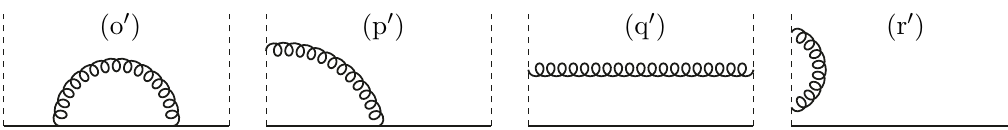
Figure 6 . One-loop Feynman diagrams with massive gluons required for the calculation of the secondary mass e(cid:11)ects, i.e. the O ( (cid:11) 2 C F T F ) terms, in the jet-function ME using the dispersion s relation in eq. (5.29). They are associated with the diagrams (o), (p), (q) and (r) in (cid:12)gure 1 with a massive quark Q bubble. Left-right mirror graphs are